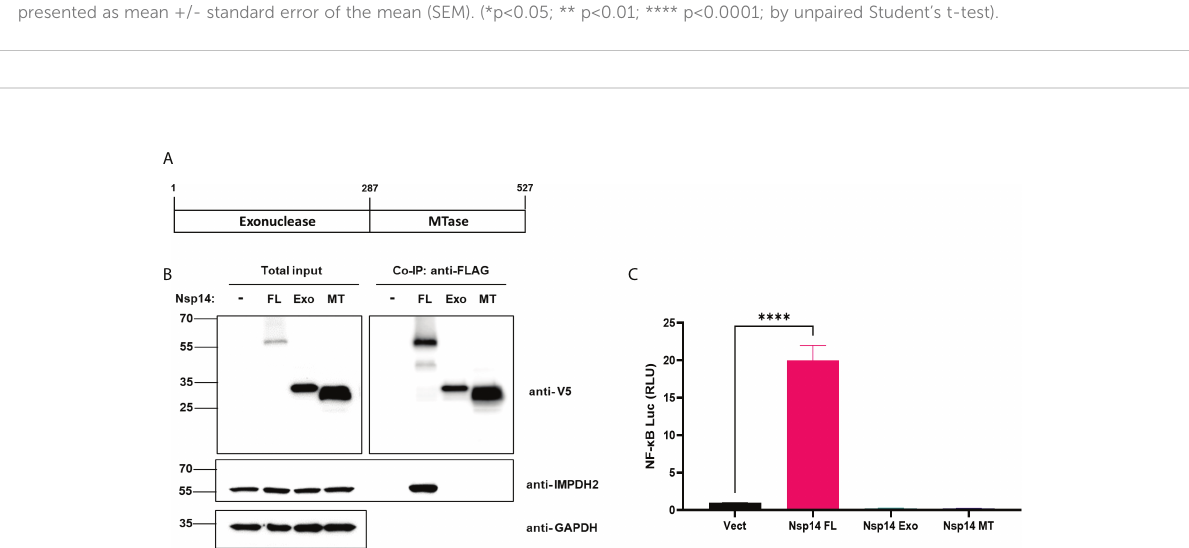
FIGURE 5 Full-length Nsp14 protein but not truncated domains interact with IMPDH2 and induce NF- k B activation. (A) We cloned the truncated Nsp14 protein to encode the exonuclease domain (Exo, aa1-287, MW ~30 kDa) or RNA methyltransferase domain (MT, aa288-527, MW ~27 kDa) with N-terminal FLAG and V5 tags. (B) pcDNA vector expressing full-length (FL), Exo, or MT Nsp14 was transfected in HEK293T cells. At 48h post of transfection, cells were harvested. Lysates were prepared and subjected to protein co-IP assays using an anti-FLAG antibody. Precipitated protein samples were analyzed by immunoblotting. (C) HEK293T cells were transfected with pcDNA vector expressing full-length (FL), Exo, or MT Nsp14, or empty vector, along with NF- k B-driven fi re fl y luciferase and TK-driven renilla luciferase reporter vectors. At 48h post of transfection, luciferase activity ( fi re fl y/renilla) was measured and normalized to the empty vector. Results were calculated from 3 technical repeats and presented as mean +/- standard error of the mean (SEM). (**** p<0.001; by one-way ANOVA and Tukey ’ s multiple comparison